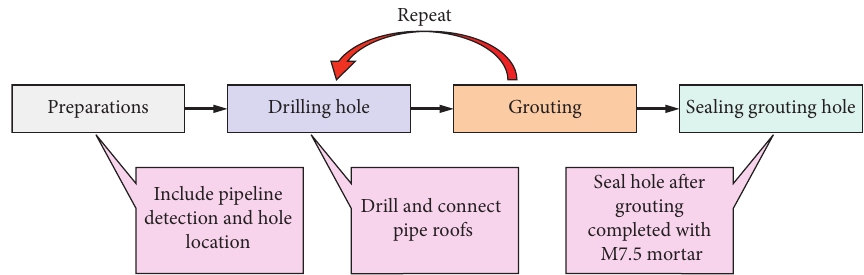
Figure 11: Process of long pipe roof setting.